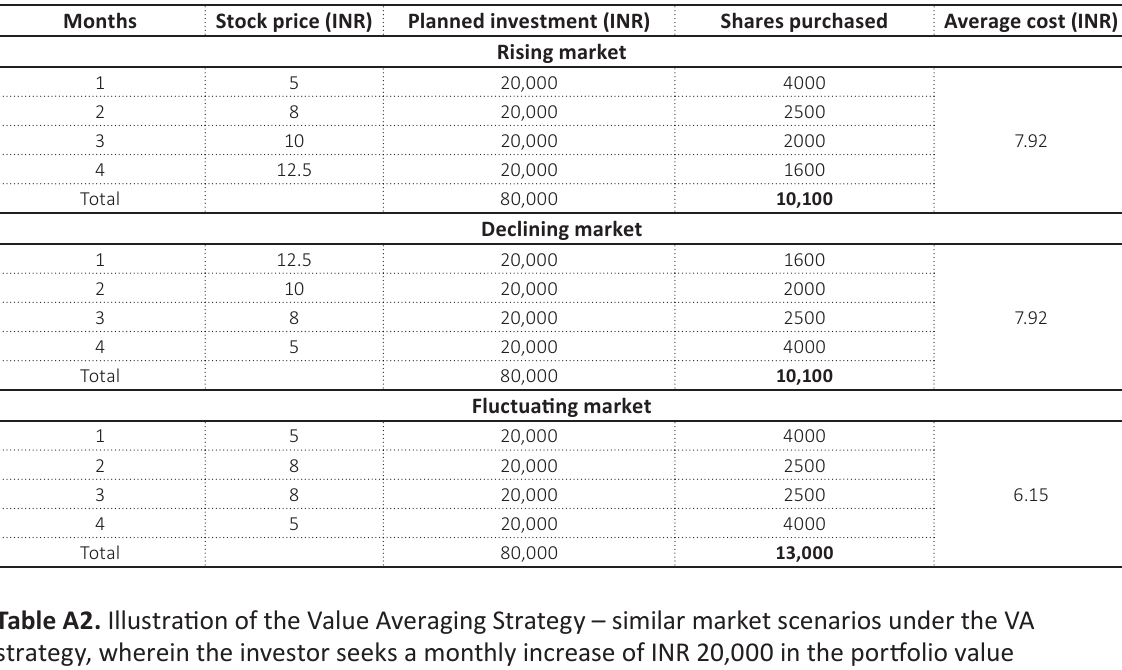
Table A1. Systematic Investment Planning (SIP) and Value Averaging (VA). Illustration of the Systematic Investment Plan – a hypothetical example with three market scenarios, where a fixed amount of INR 20,000 is invested for four months under SIP